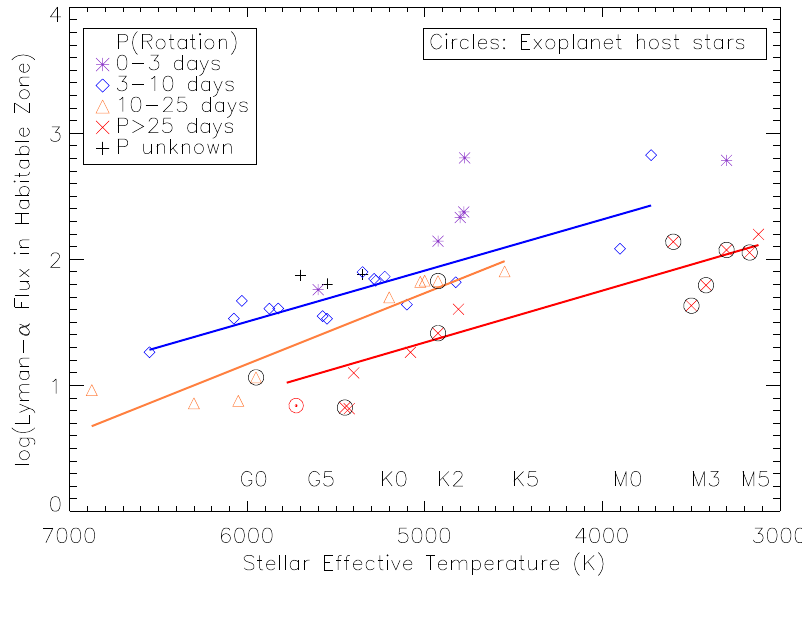
Figure 10. Lyman- α flux in the habitable zones around stars vs. stellar effective